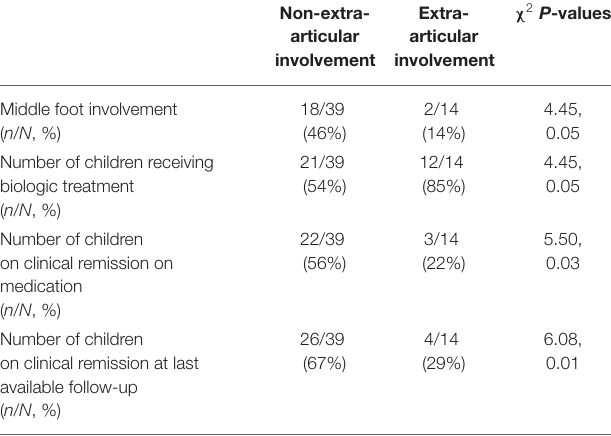
TABLE 2 | Comparison statistics stratifying into extra-articular- vs. non-extra-articular